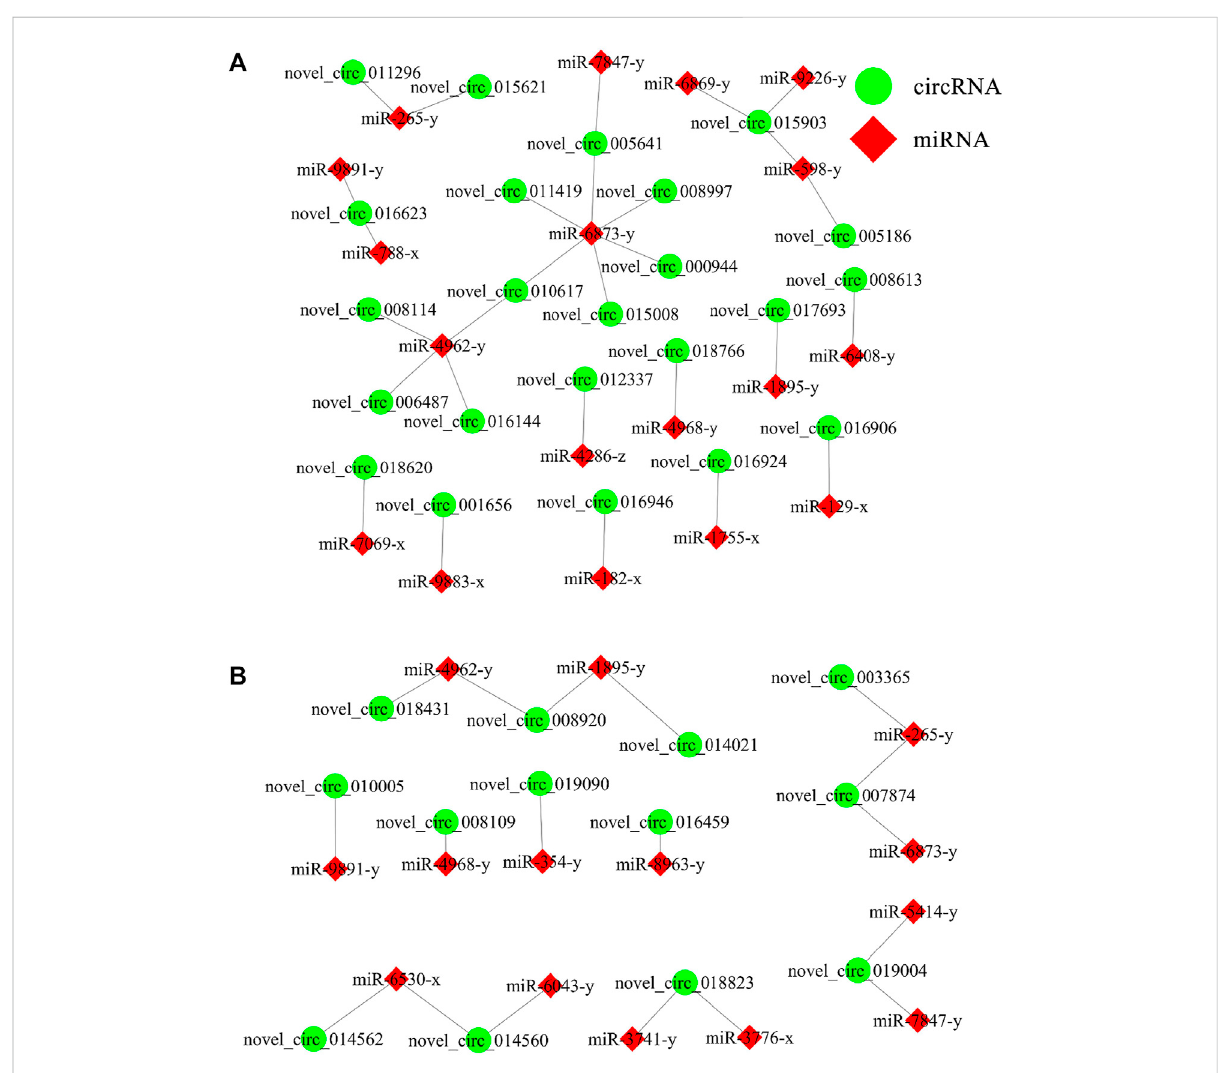
FIGURE 5 DEcircRNA-miRNA network engaged in N. ceranae -response of A. c. cerana workers. (A) Regulatory network in AcCK1 vs AcT1 comparison group (B) Regulatory network in AcCK2 vs AcT2 comparison